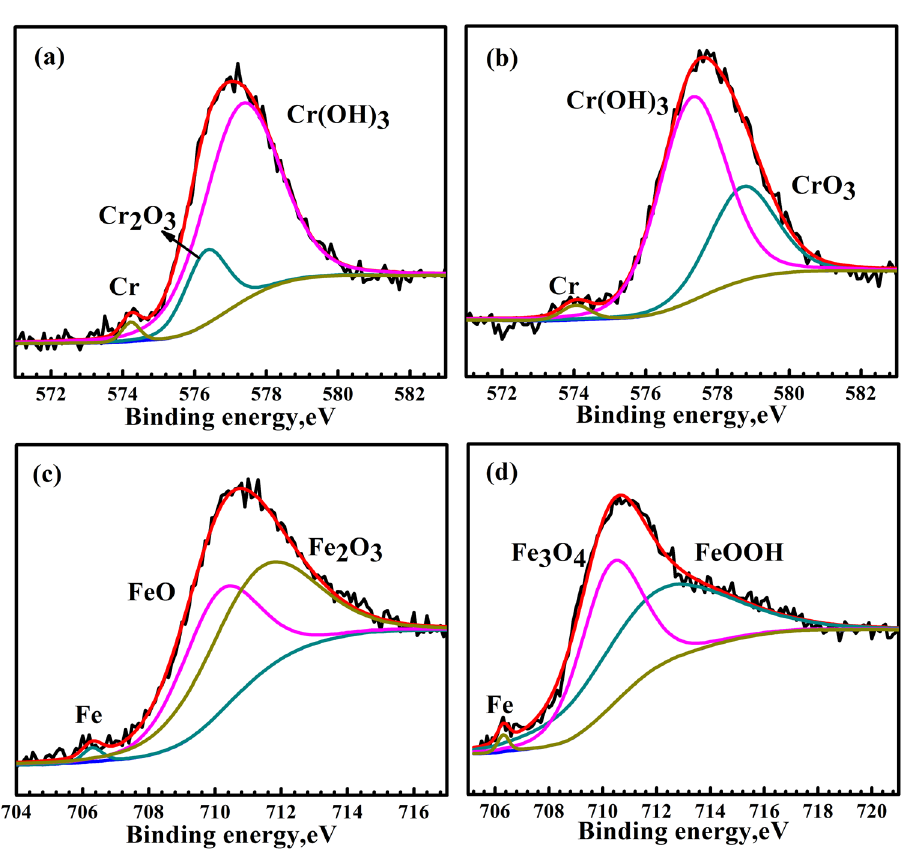
Figure 3. XPS spectra of Cr 2p 3/2 and Fe 2p 3/2 of the passive films formed on the uncharged surface ( a , c ) and hydrogen-charged surface ( b , d